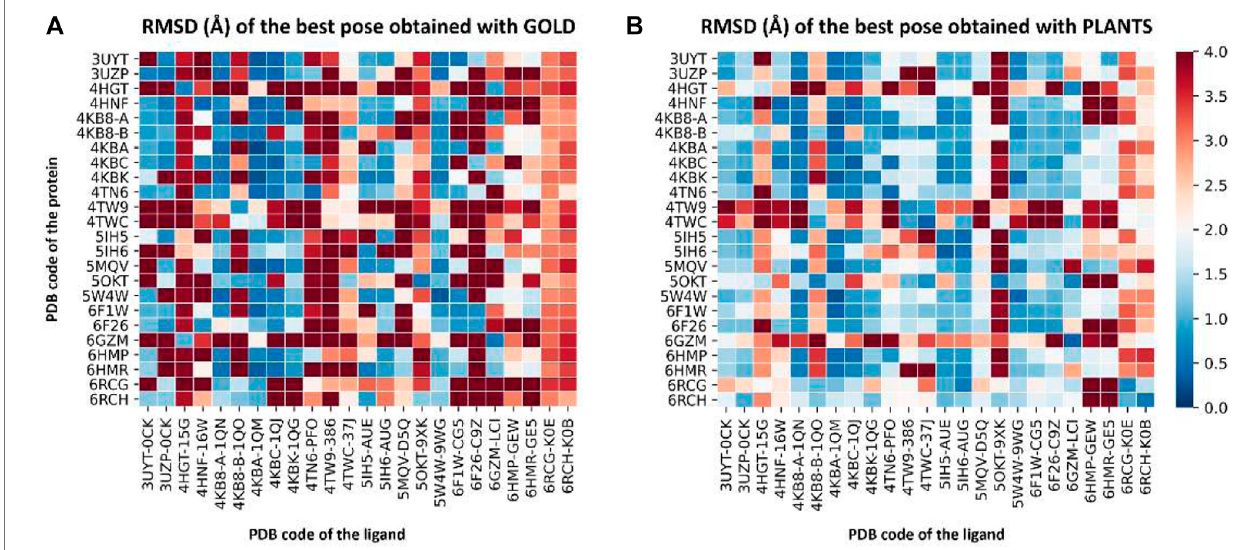
FIGURE 2 | Two heatmaps that summarize the results of the cross-docking experiment performed before the Autogrow runs to select the protein structure to use for subsequent calculations. Panel (A) reports the results for the GOLD-Chemscore protocol, while Panel (B) encompasses the results of the PLANTS-PLANTS ChemPLP one. On the vertical axis, the PDB code of the protein is reported, while on the horizontal axis the PDB code of the ligand is indicated. The colored squares report the RMSDvaluesforthebestdockingposegeneratedbythetwodockingprotocolsaccordingtothecolorbarlocatedontherightsideoftheimage:colorrangesfrom blue(indicatingalowRMSD;minimumvalueis0 Å,indicatingaperfectsuperpositionbetweenthedockingposeandthecrystalreference)tored(maximum valueis4 Å, indicating a high deviation between the docking pose and the crystal